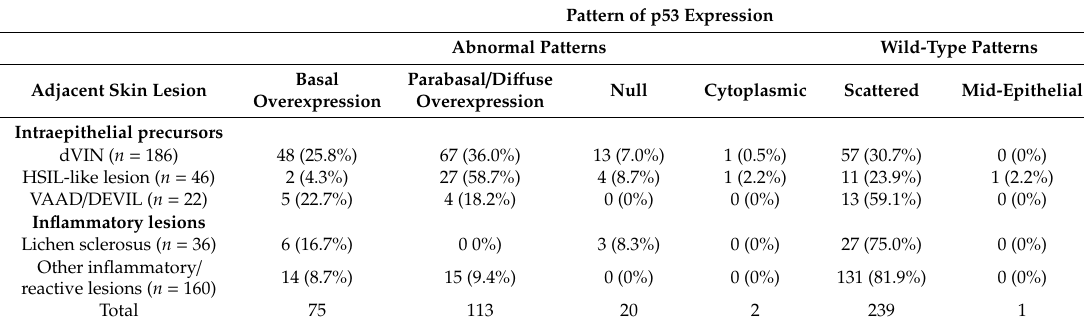
Table 1. Immunohistochemical expression of p53 in the di ff erent intraepithelial lesions adjacent to vulvar squamous cell carcinoma (VSCC). Pattern of p53 Expression